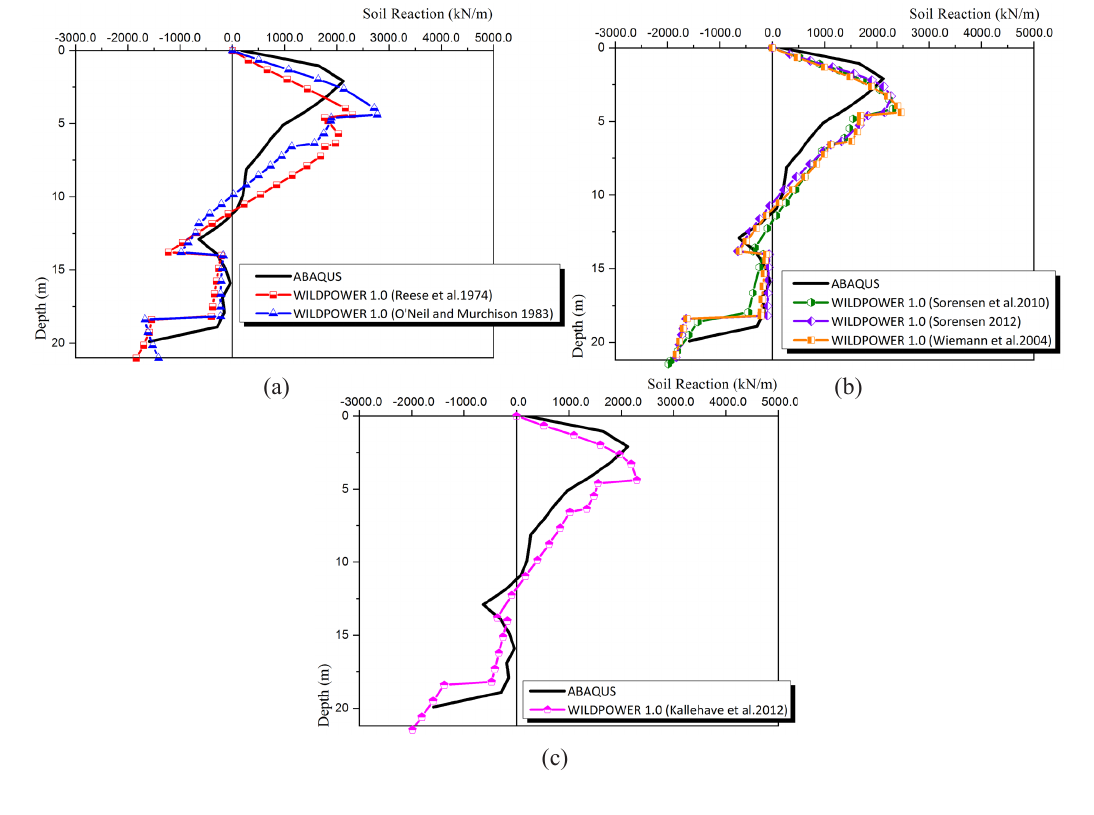
Figure 7: Profiles of soil